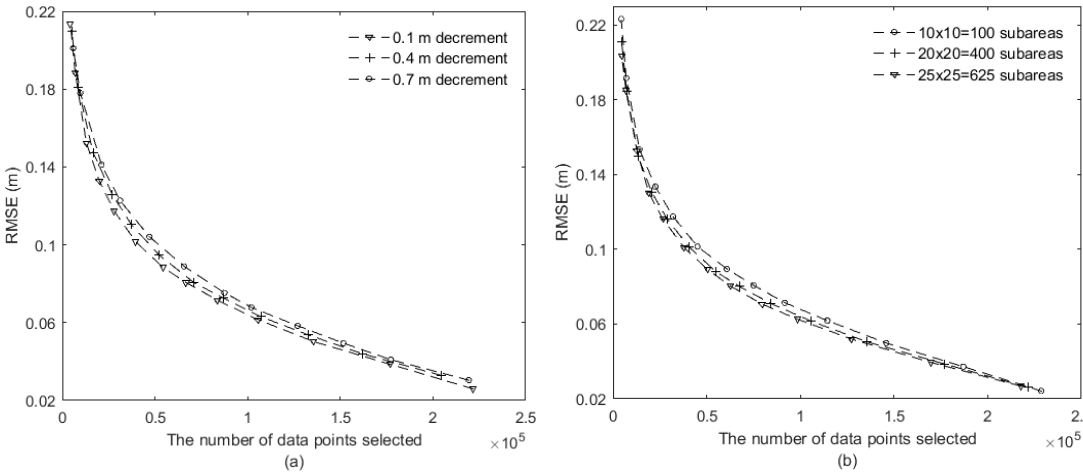
Figure 9. The coarse-to-fine method for the hilly rough surface: ( a ) the effect of the decreasing interval of voxel edge length under the same number of 20 × 20 = 400 sub-areas, ( b ) the effect of the sub-area size under the same decreasing interval of 0.2